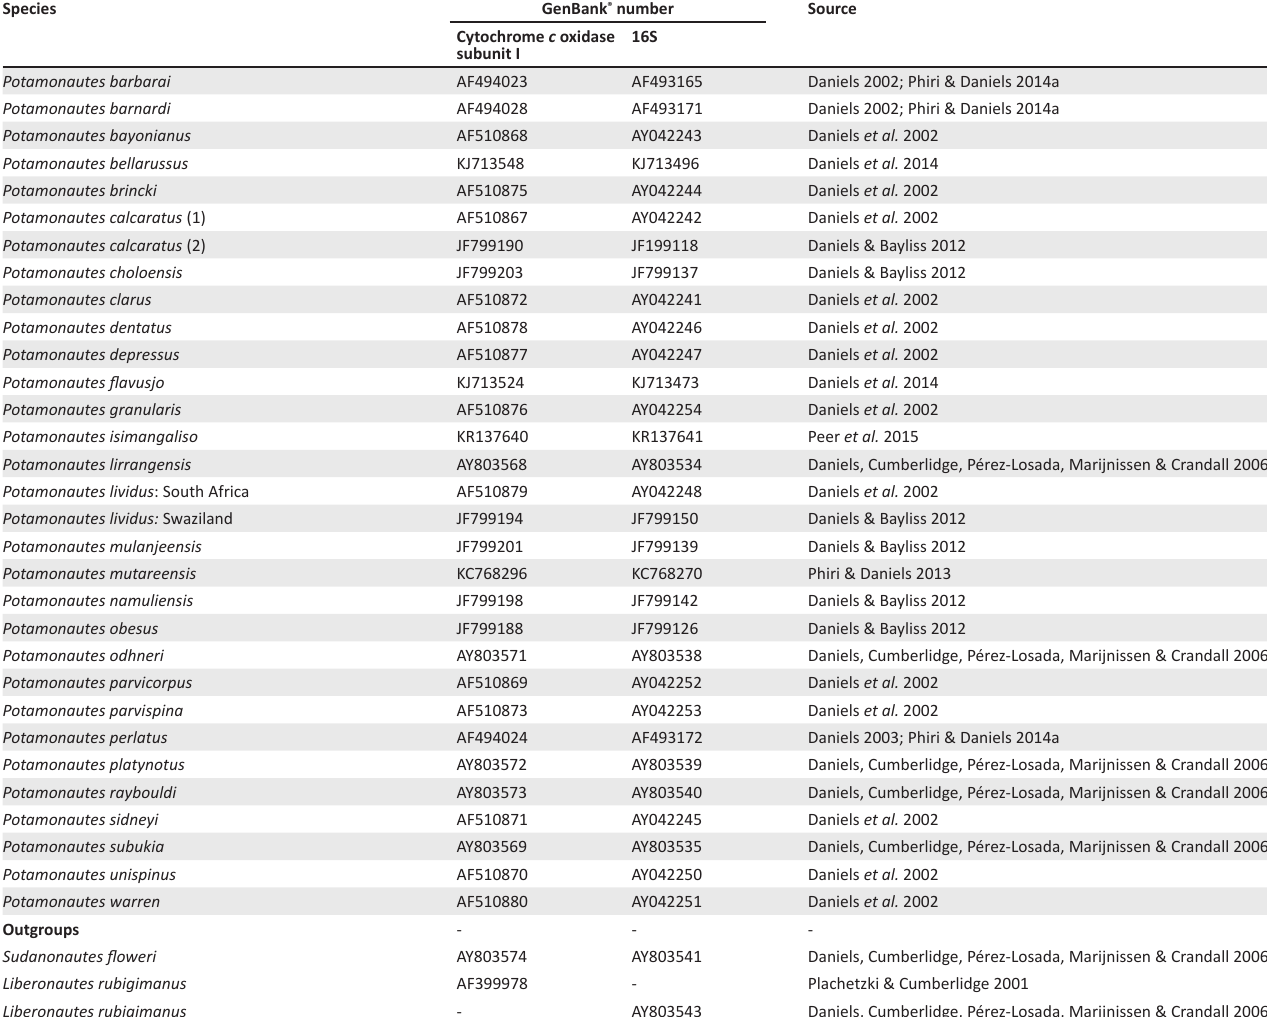
TABLE 1: Southern and Eastern African Potamonautes species included in the phylogenetic analysis. Liberonautes latidactylus and Sudanonautes aubryi were included as outgroup taxa. GenBank ® accession numbers for the cytochrome c oxidase subunit I and 16S ribosomal DNA sequences are included and the data sources provided.